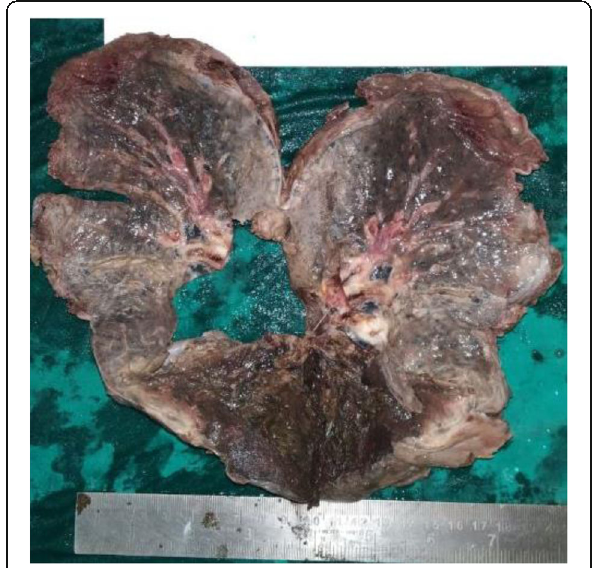
Fig. 4 Cut surface of gross pneumonectomy specimen of the right lung showing a large cavity with necrosis and angioinvasion